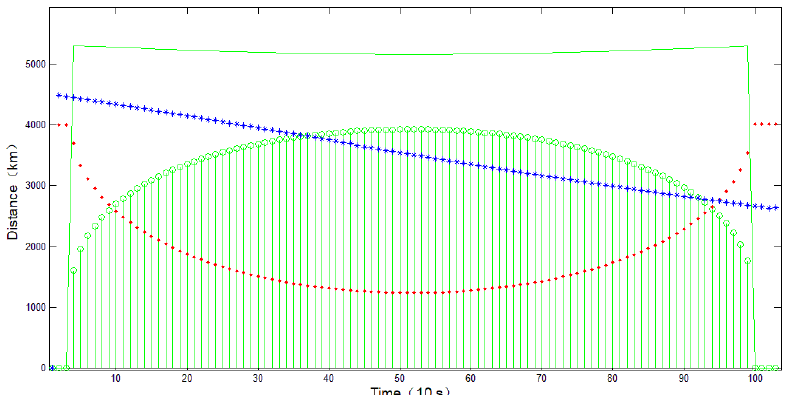
Figure 7. Time sequence of detection area variation.